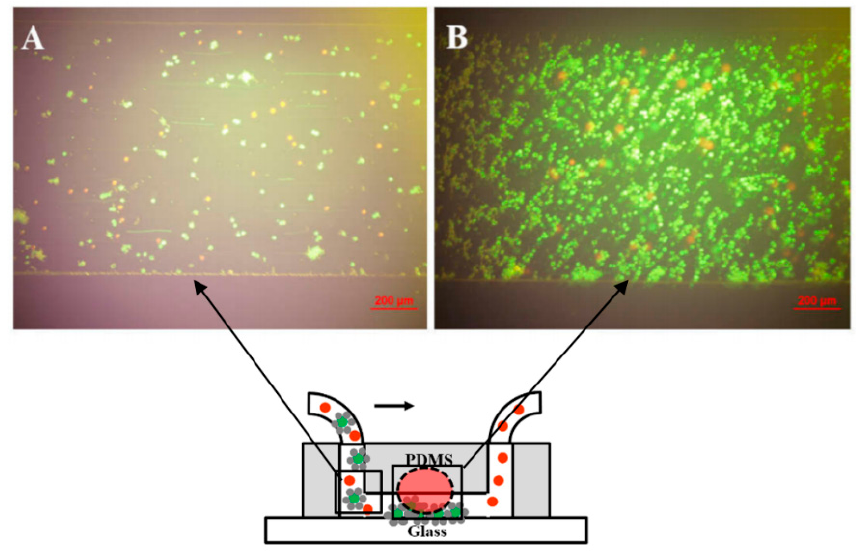
Figure 5. Fluorescent images of the A549 cells and HeLa cells at different positions in the microfluidic channel of the isolation system. ( A ) Image of non-magnet position. ( B ) Image of the position applied permanent magnet.